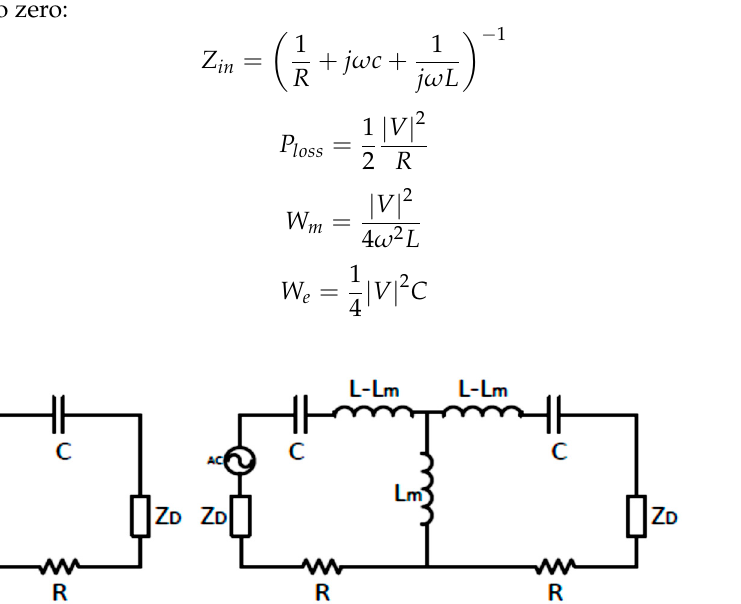
Figure 2. Equivalent circuit for magnetic resonance.